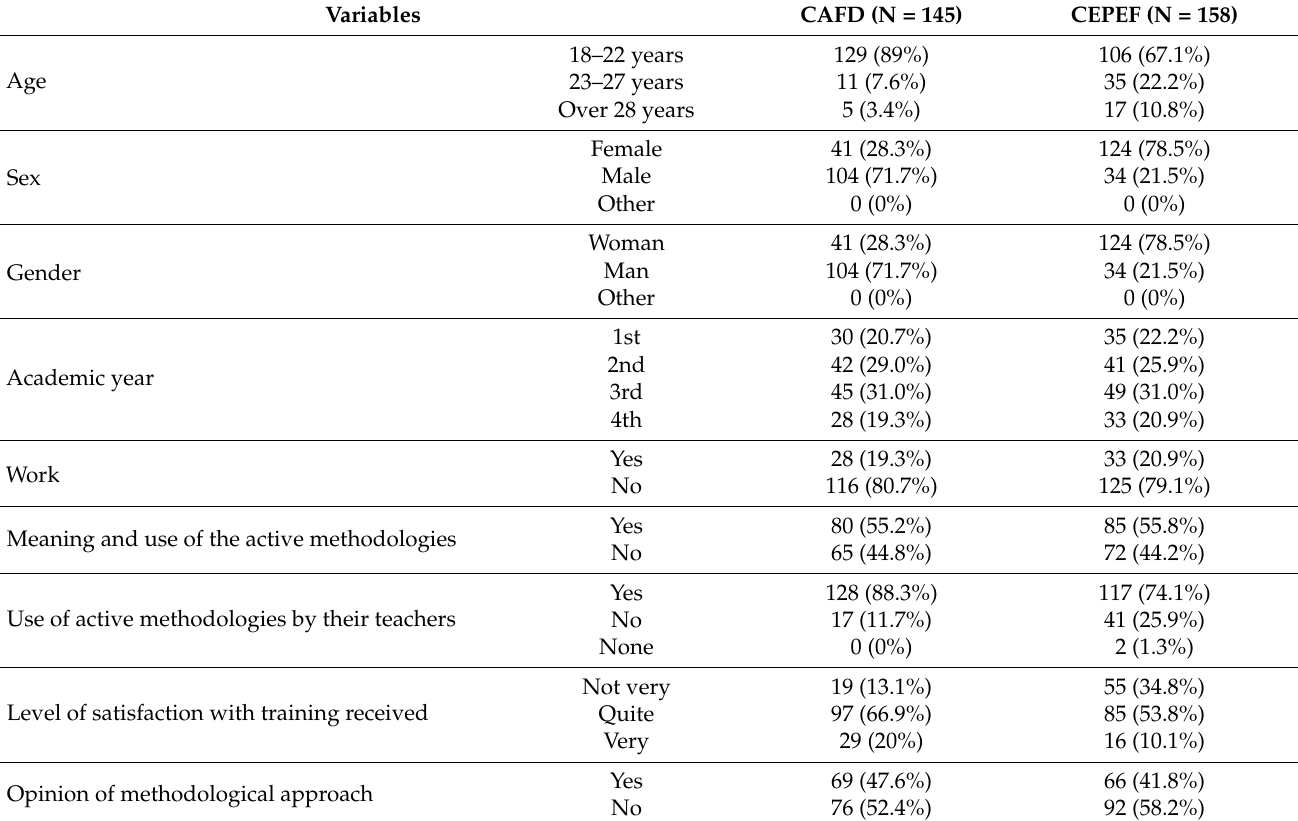
Table 1. Sociodemographic, academic and relational data of the 303 students